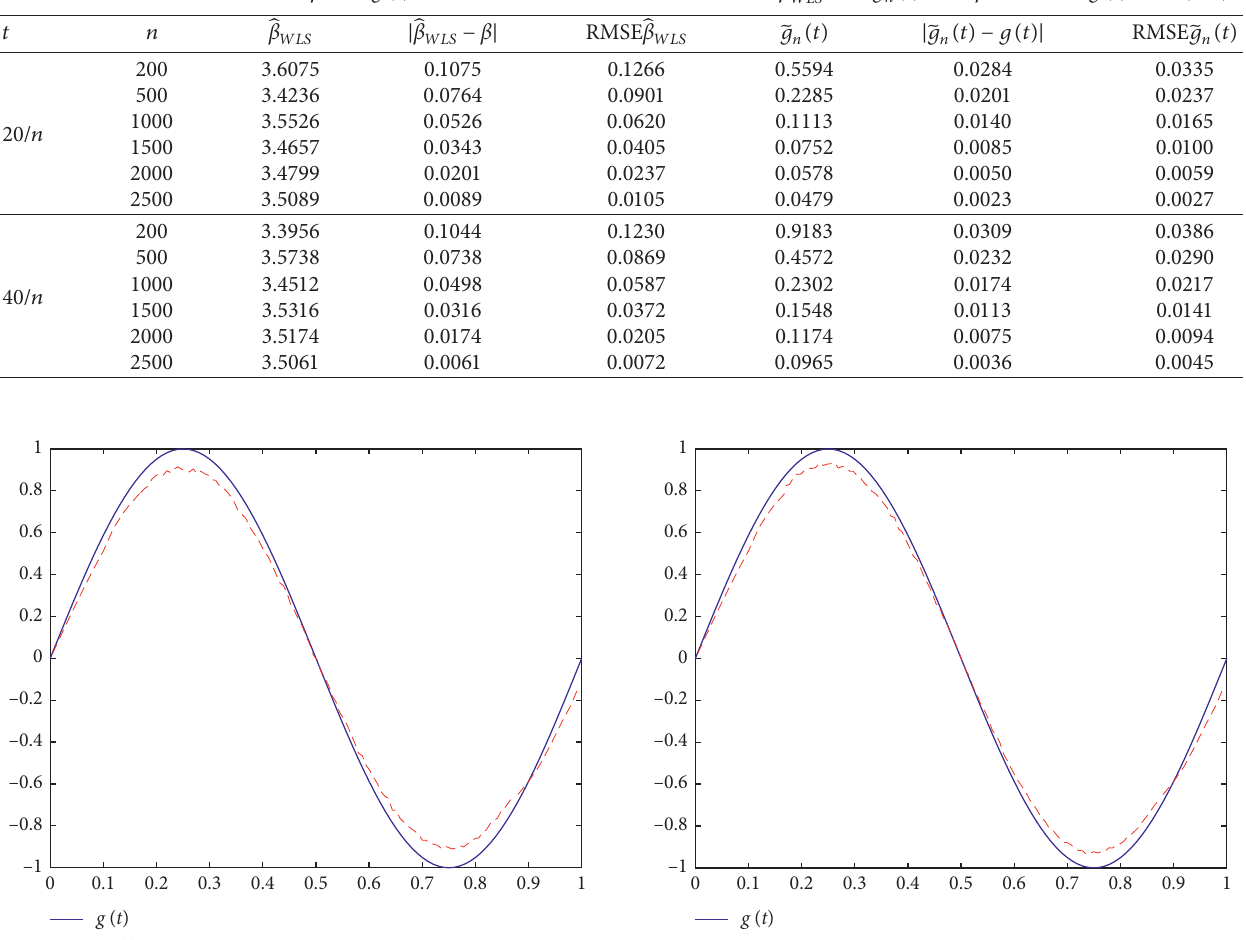
Table 1: The LS estimators of β and g ( t ) and the absolute errors and RMSEs of 􏽢 β